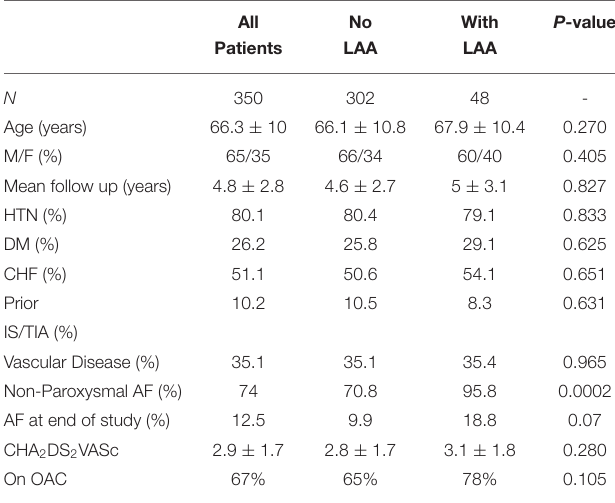
TABLE 1 | Baseline demographics*.